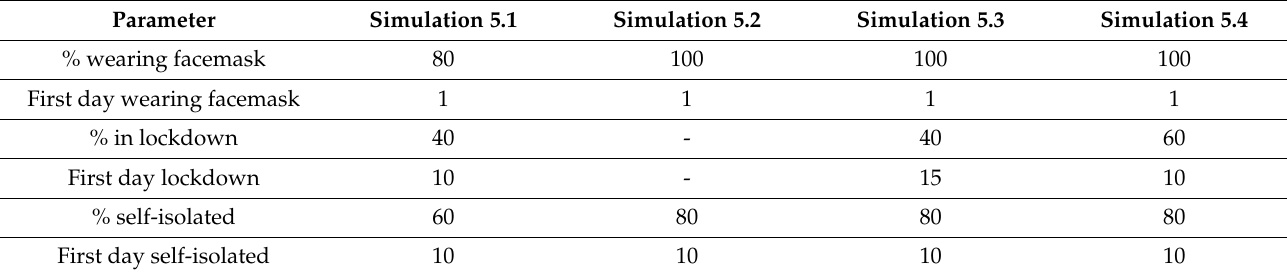
Table 8. Parameters used in each simulation for Scenario 5 to reduce the risk when measures were combined.